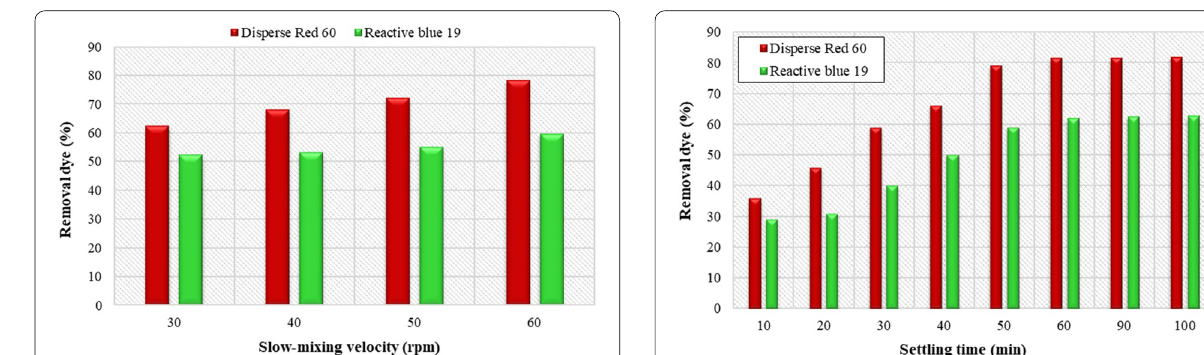
68%, respectively.